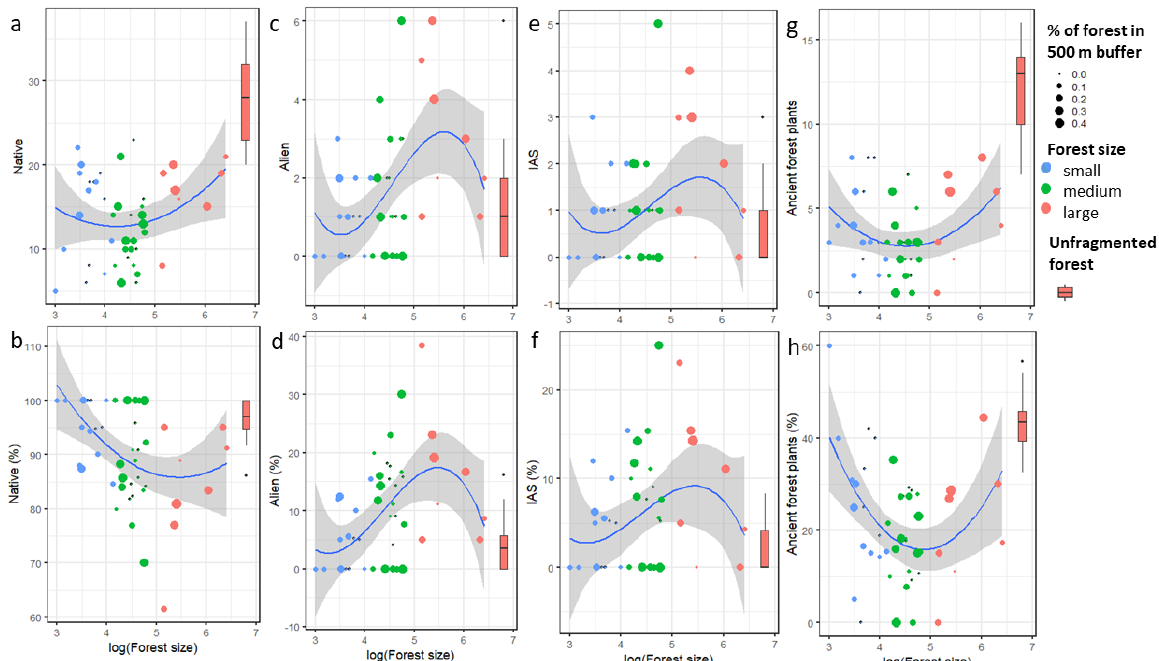
Figure 1. Effect of forest fragment size on richness ( a ) and proportion ( b ) of native plant species, alien ( c , d ), invasive alien ( e , f ), and ancient forest plants ( g , h ) in a plot. The color and size of the dots correspond to the forest fragment size group and % of forest cover in 500 m buffer, respectively. Control unfragmented forest Murska šuma is shown by a bar (minimum, 1st quartile, median, 3rd quartile, maximum).